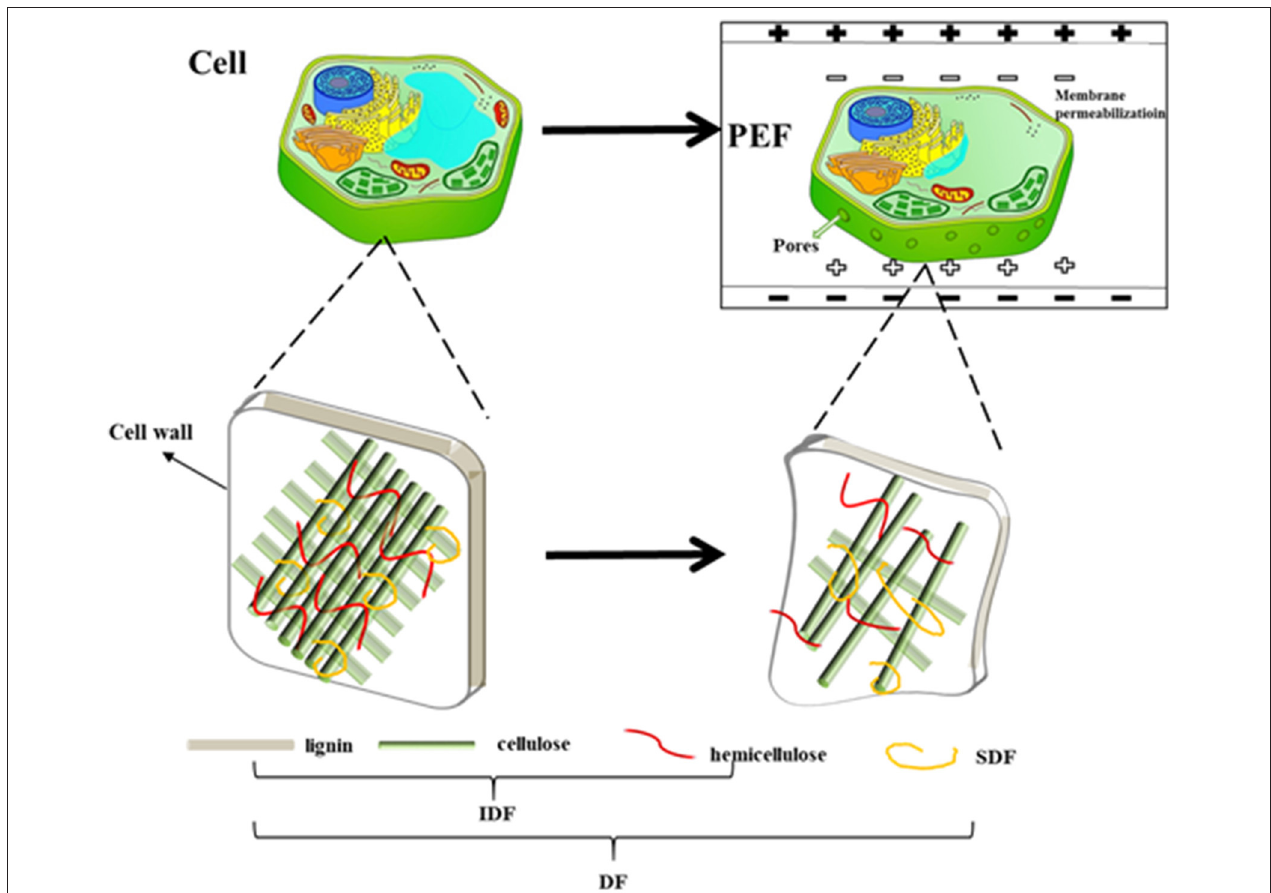
FIGURE 9 | The mechanism of PEF assisted-extraction of the SDF from orange